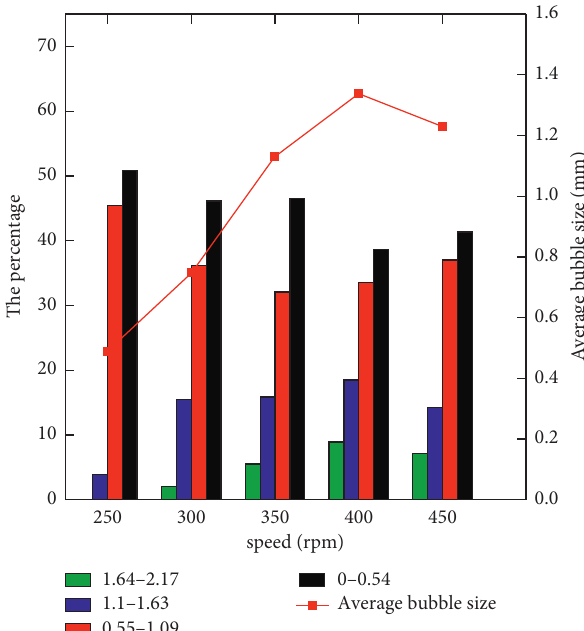
Figure 19: The size distribution of bubbles at different